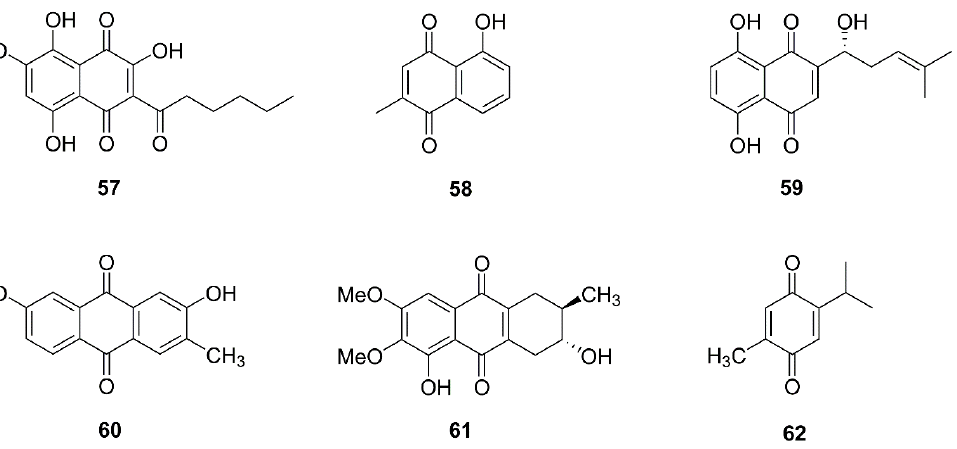
Figure 7. Chemical structures of quinines ( 57 – 62 ).